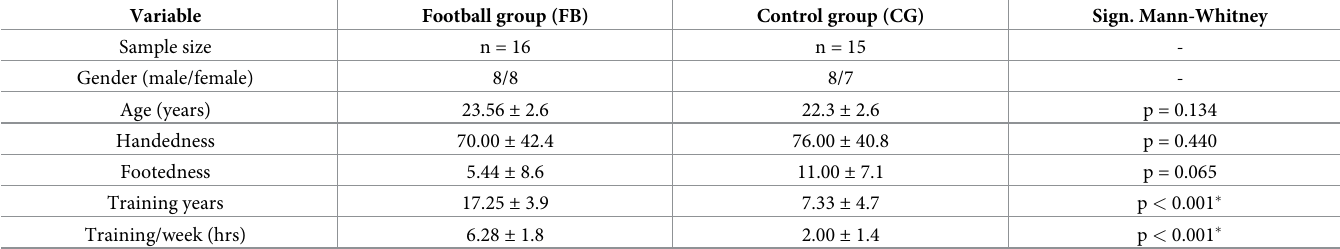
Table 1. Overview of participant